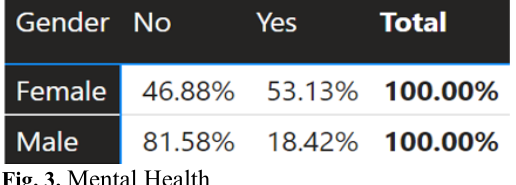
Fig. 3. Mental Health Finding 3: Reason for being frustrated too often.